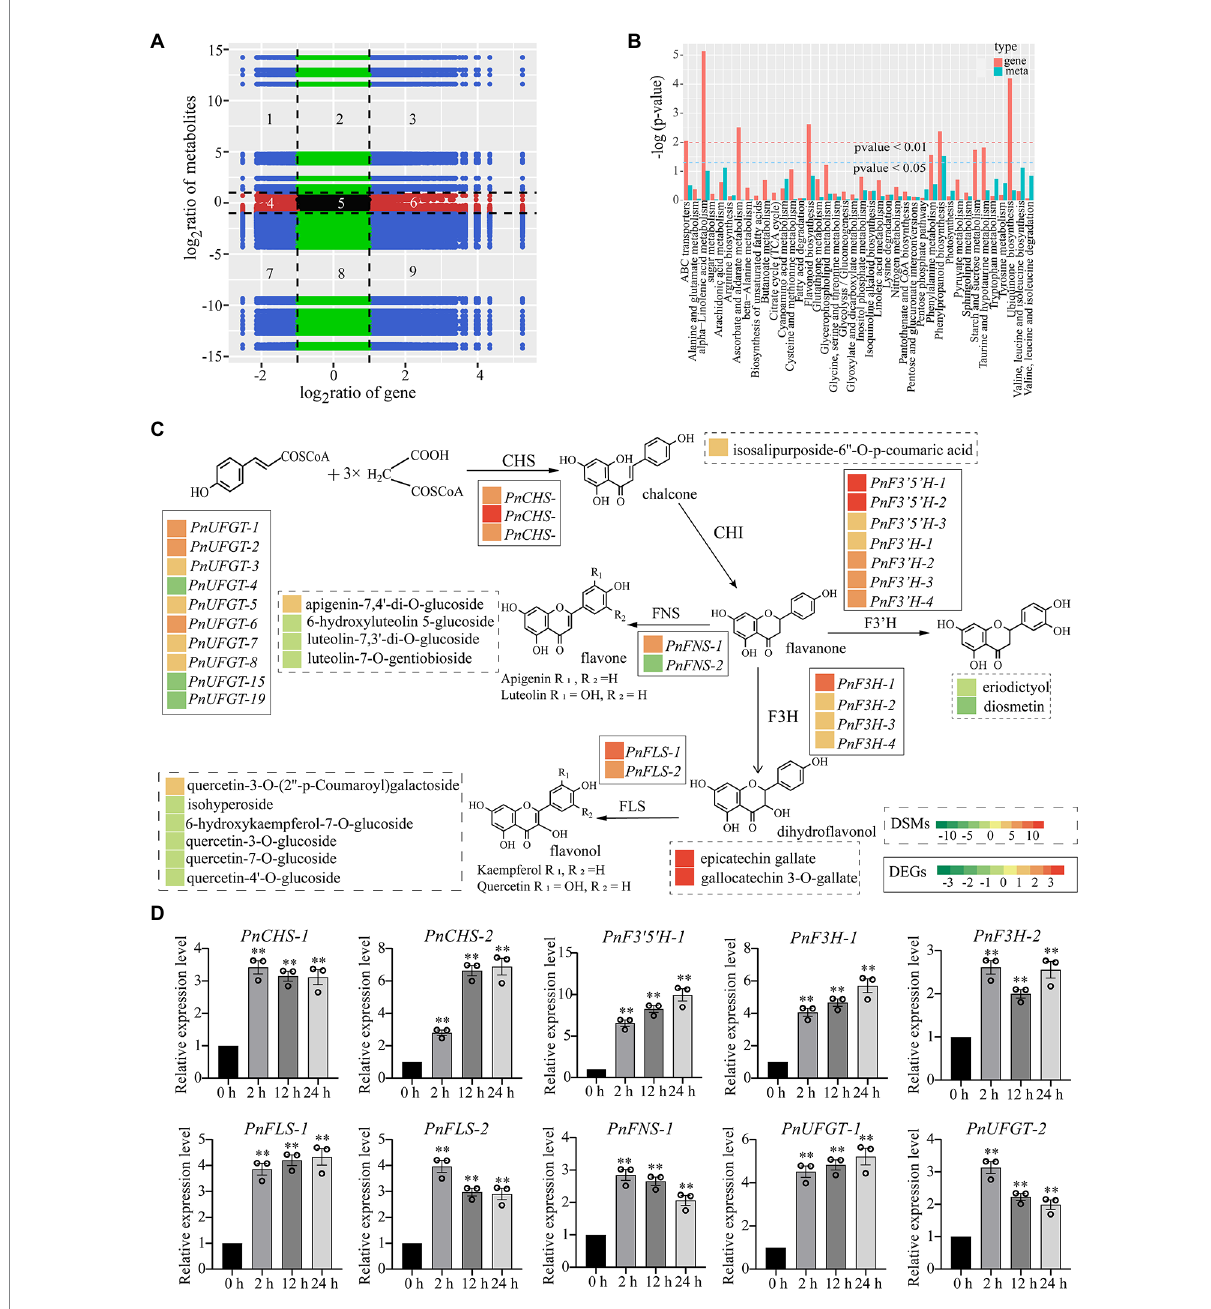
FIGURE 6 Integrated transcriptome and metabolome analysis highlighted the essential role of flavonoid pathway under drought stress. DCMs in PEG60h vs. CG and DEGs in PEG6000-treatment vs. CG were used for integrated transcriptome and metabolome analyses. (A) Correlation between the metabolites and transcript levels of the genes. There were no differential changes in genes and metabolites within the red, green, and black regions. The blue area represents a differential change, which is statistically significant. Pearson correlation coefficients for genes and metabolites were calculated using the cor program in R. (B) Integrated analysis of KEGG enrichment pathways for transcriptome and metabolome data. Horizontal ordinate indicates metabolic pathways, red on the ordinate indicates enrichment values for differential genes, and light blue indicates enrichment values for differential metabolites. Vertical ordinate indicates the significance of metabolic pathway enrichment. (C) Heatmap analysis of metabolites accumulation and differentially expressed genes in flavonoid pathway. The left color block of each gene and metabolite indicated the log 2 (Fold change) of this gene and metabolite under drought stress. Genes labeled in solid line box and metabolites showed in dotted box. (D) qPCR analysis confirmed that flavonoid synthase genes were upregulated under drought stress. CHS, chalcone synthase; F3 ′ 5 ′ H, flavonoid 3 ′ , 5 ′ -hydroxylase; F3H, flavonone 3 β -hydroxylase; FNS, flavones synthase; FLS, flavonol synthase; UFGT, UDP-glucose: flavonoid 3-O-glucosyltransferase. The data were calculated from three biological replicates. Vertical bars are means ±SE. Significant difference ( ** p <